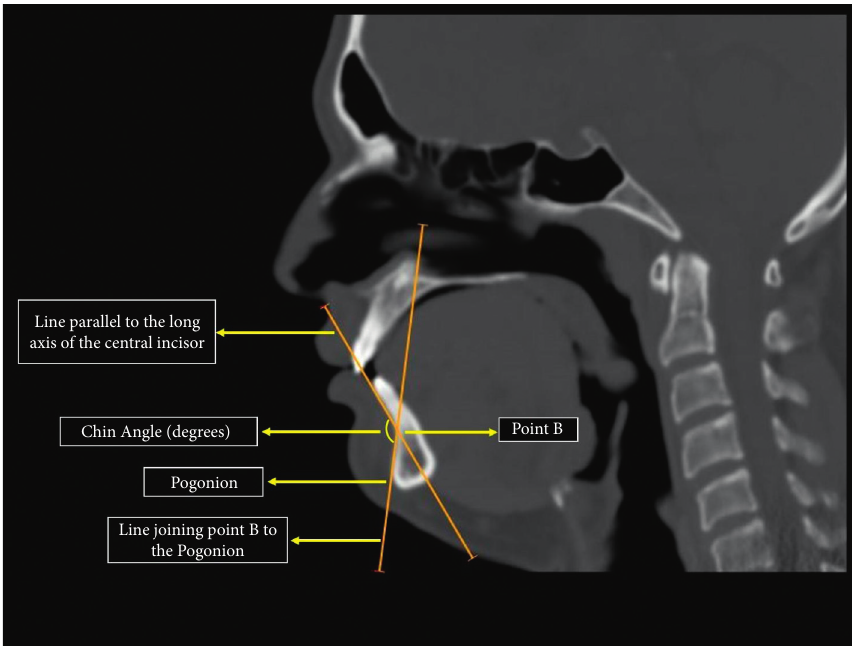
Figure 2: The chin angle depicted in the midsagittal CT scan.